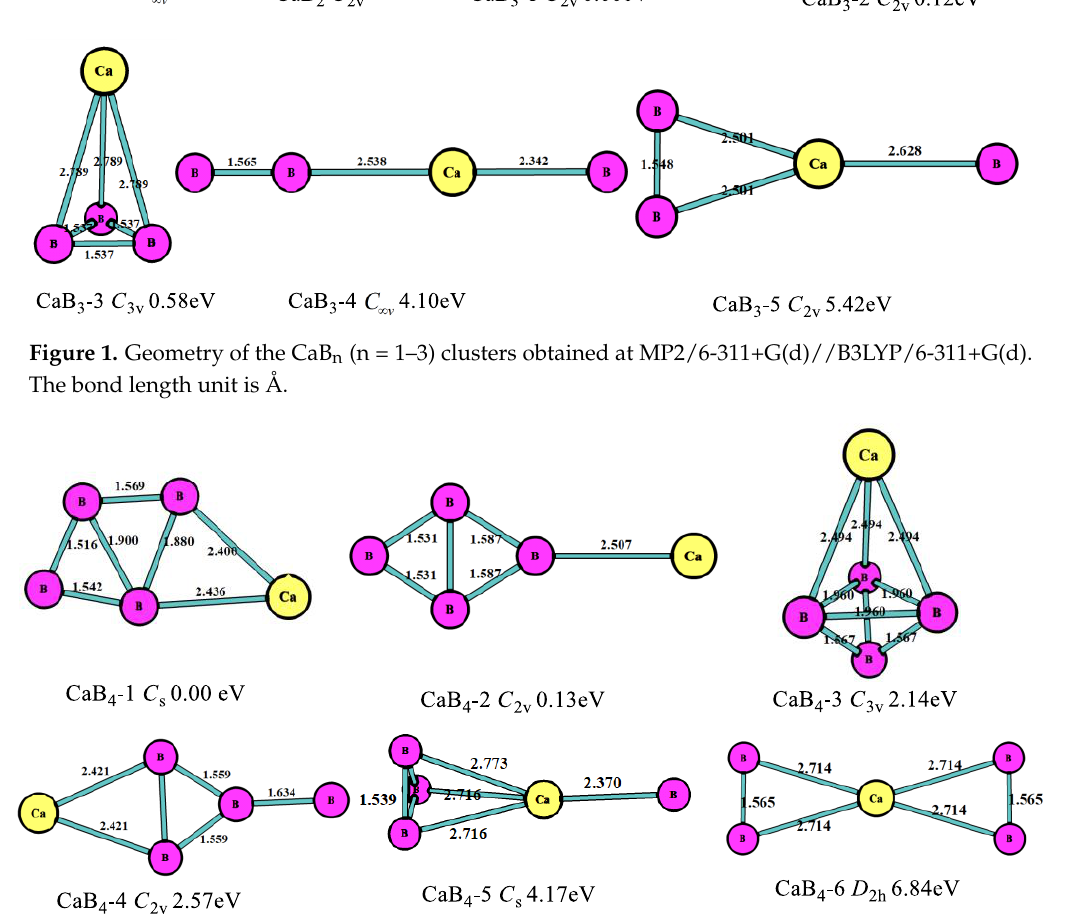
Figure 1. Geometry of the CaB n (n = 1 – 3) clusters obtained at MP2/6-311+G(d)//B3LYP/6-311+G(d). The bond length unit is Å .